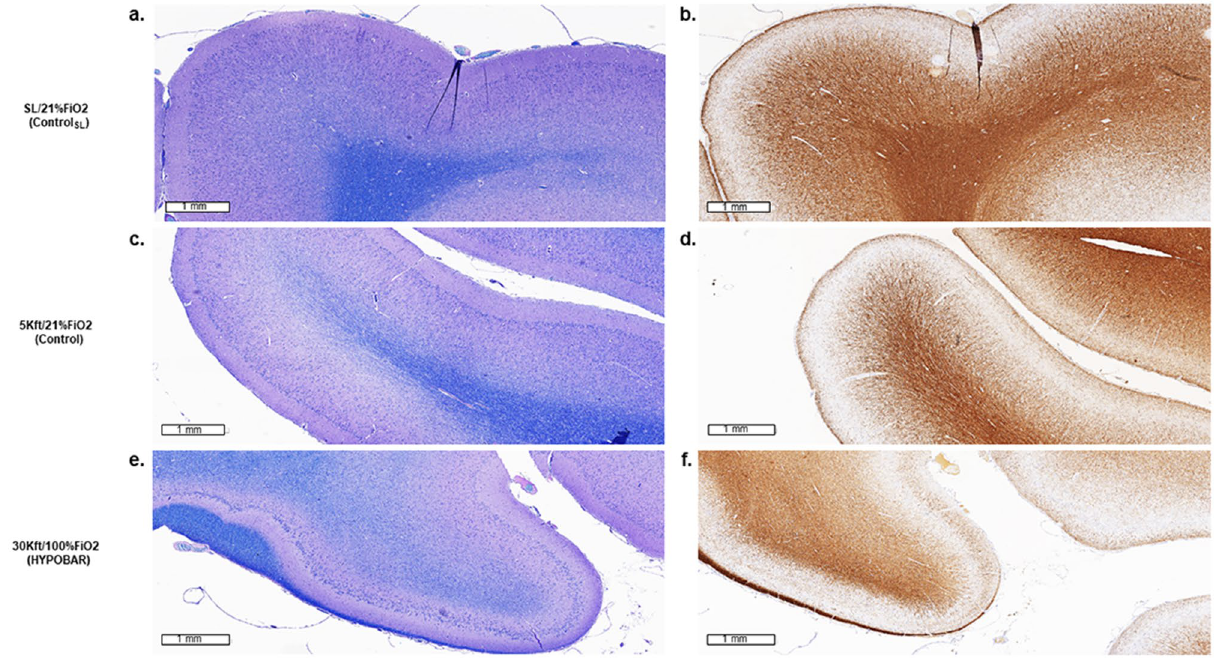
Figure 1. Luxol-fast Blue (LFB) stain ( a , c , e ) and immunohistochemistry (IHC) outcomes of MBP (myelin basic protein) antibody ( b , d , f ) in the left parietal cortex of minipig brains exposed to different oxemic and barometric conditions. All panels are at a scale of 1 mm (mm). Note the marked level of myelin rarefaction ( e , f ) in the cortical white matter of HYPOBAR vs. the other two experimental groups [CSL ( a , b ) and C ( c , d ) group]. SL sea level, FiO 2 fraction inspired oxygen, HYPOBAR nonhypoxic-hypobaric condition, ft feet, ControlSL SL/21%FiO 2 , Control 5Kft/21%FiO 2